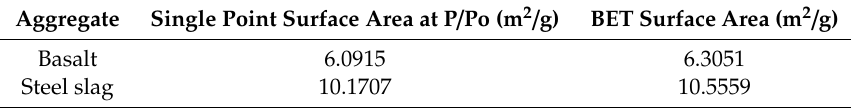
Table 3. Surface area of basalt and steel slag.